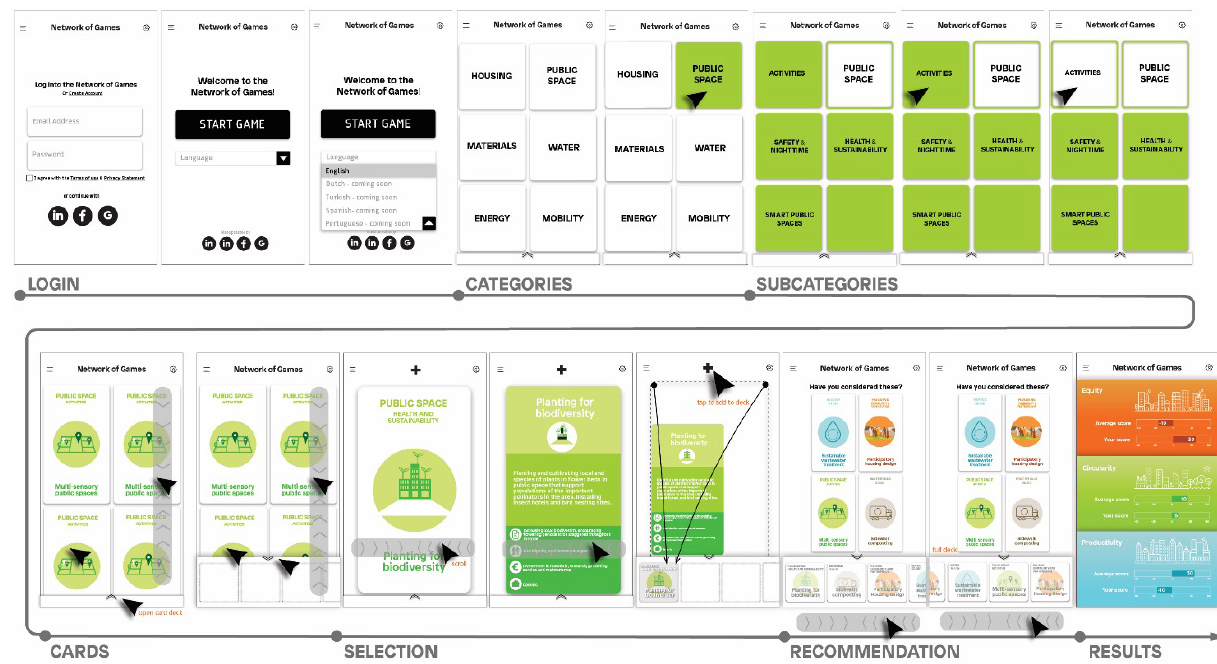
Figure 6. The wireframe. homeowners ) on site. The rest seven meetings took place with various city departments of the city of Amsterdam, expert organizations, and with the generation of the digi‐ tal app with advisors committee and students (Figure 8).